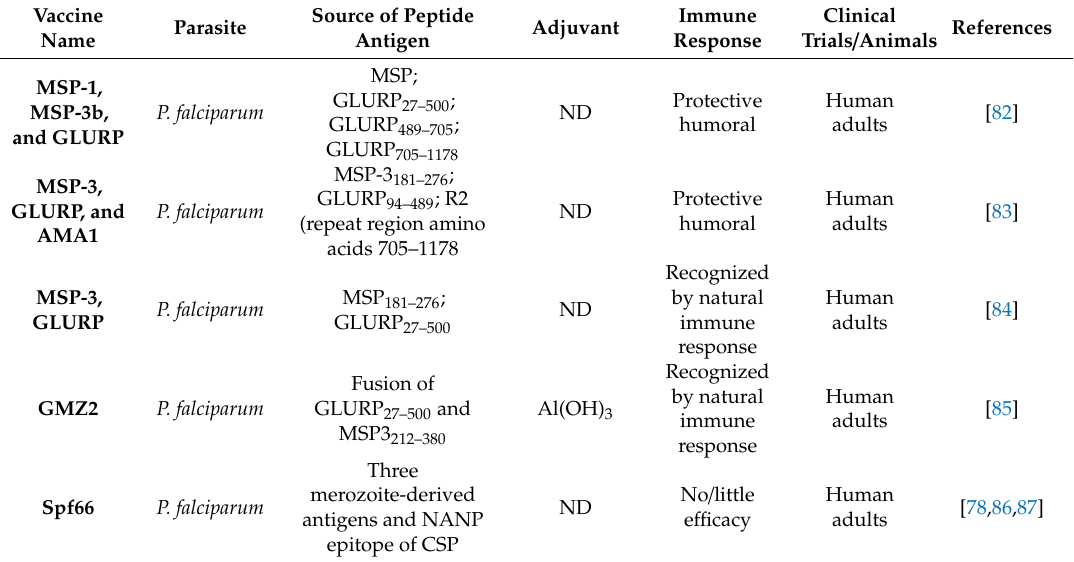
Table 2. Erythrocytic peptide-based vaccines constructs against